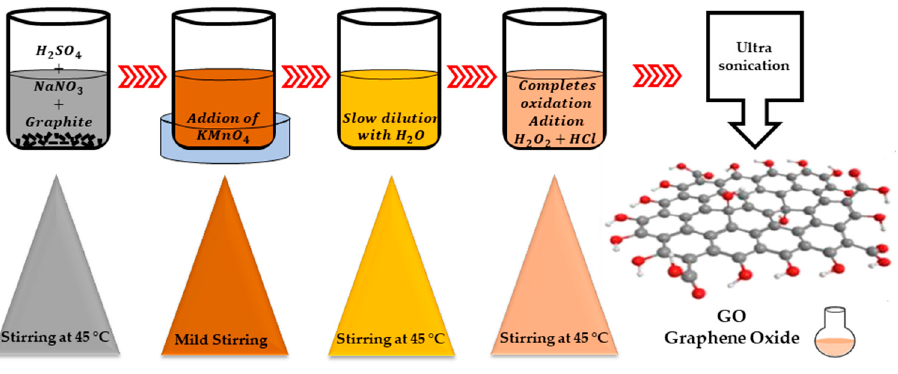
Figure 1. Hummer’s method.